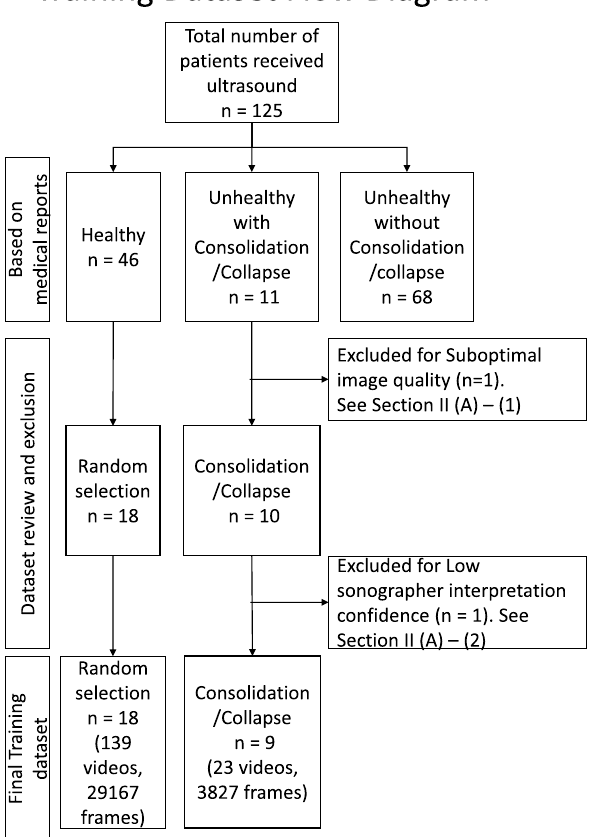
Figure 2. Distribution of the patients before any processing (original dataset) to the final training dataset (after processing, data exclusion, and clinical